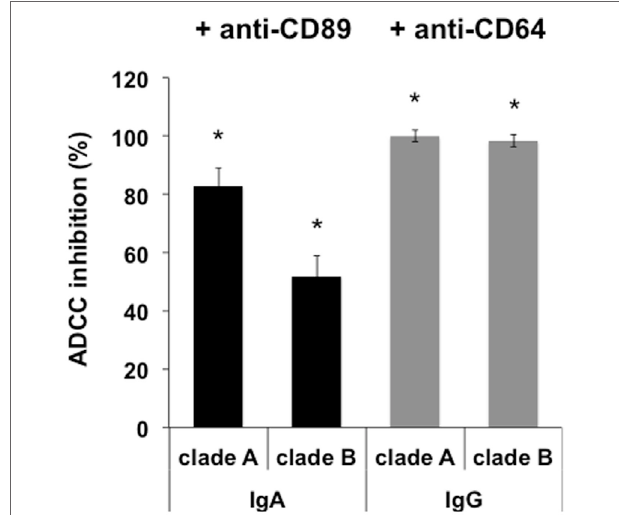
FigUre 4 | Antibody-dependent cellular cytotoxicity (ADCC) depends on Fc α RI and Fc γ RI. Monocytes were preincubated or not with either anti-CD89- or anti-CD64-blocking antibody for 1 h at 37°C before incubation with double-stained CD4 + T CEM-NK r cells coated with P1. Target cell lysis was evaluated as shown in Figure 3 . Values represent the percent of ADCC- induced cell lysis reduction in the presence of monocytes preincubated with anti-CD89 or anti-CD64 antibody. Values represent mean inhibition ± SEM. * p < 0.005, unpaired Student’s t -test compared to ADCC in the absence of